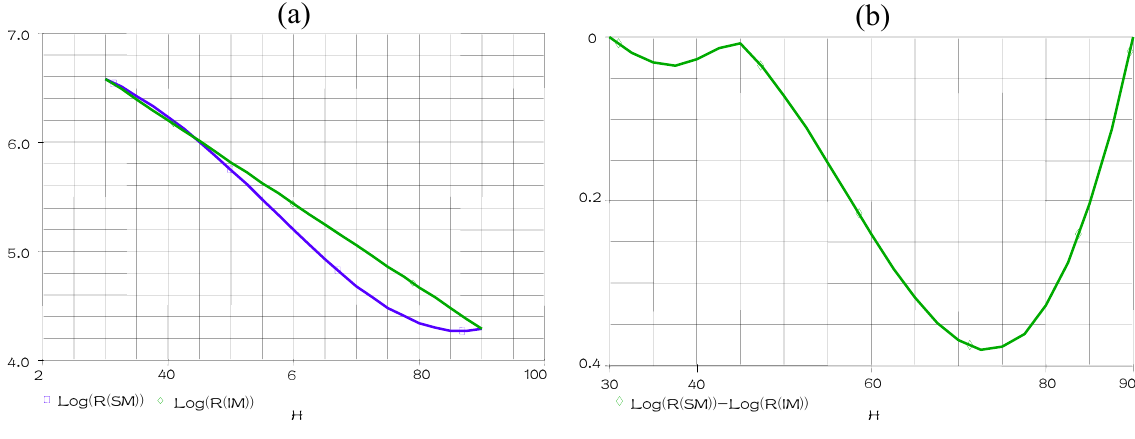
Figure 8. (a) The delivered resistances R sample 1 (b) The delivered resistance Rerror │ (Log(R(SM)-Log(IM))) │ , by a DC SWEEP analysis for sample